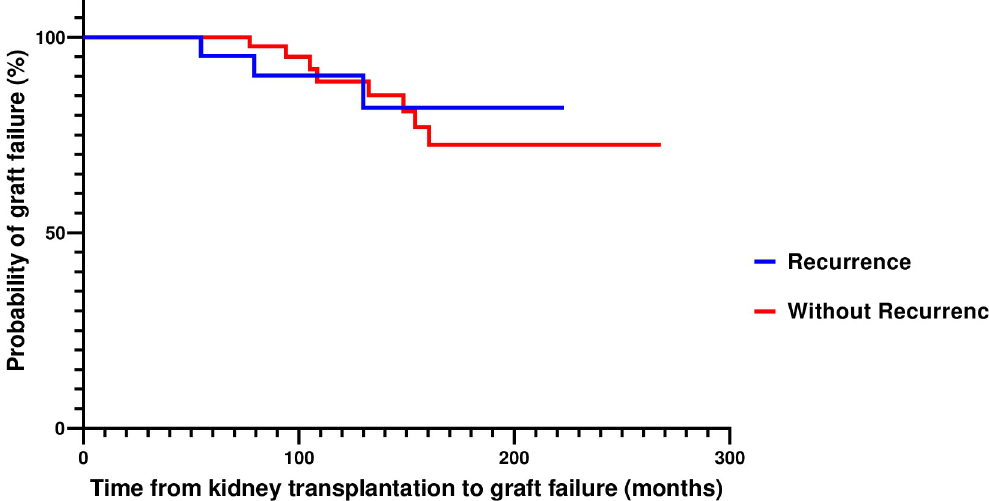
Fig 3. Kaplan Meier estimates of death-censored graft survival in patients with IgAN recurrence in the graft and those without recurrence.